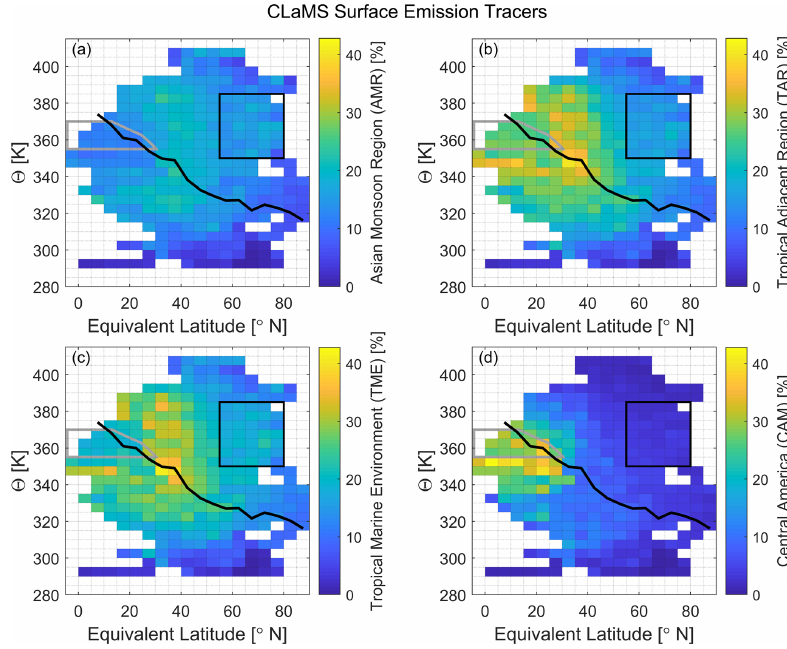
Figure 10. Relative contribution of surface emission tracers during the WISE campaign. The individual surface regions are displayed in Fig. 9. The Asian monsoon anticyclone region (AMR), consisting of NIN, IND, INO, TIB, ECH, and BoB (a) , and its tropical adjacent region (TAR), consisting of Wpool, SEA, TWP, TEP, NAF, and Neast (b) , contribute the largest fractions of surface air to the LMS HBrR (indicated by the black box; see text for details). A subgroup of these regions, the tropical marine environment (TME consisting of SEA, Wpool, BoB, INO, TWP, and TEP) is particularly significant due to elevated emissions of brominated VSLS (c) . The contribution from Central America (CAM) to the tropical UT/TTL is largely due to vertical transport of air by hurricanes Maria and Ophelia in fall 2017 (d) . The gray outline marks the tropical (cid:50) high –PV low region, and the solid black line is the average WMO